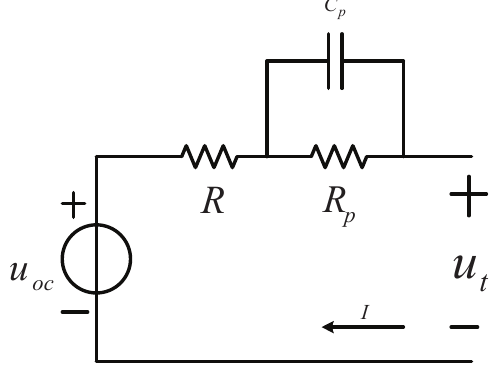
Figure 1. Thevenin equivalent model for lithium-ion batteries.